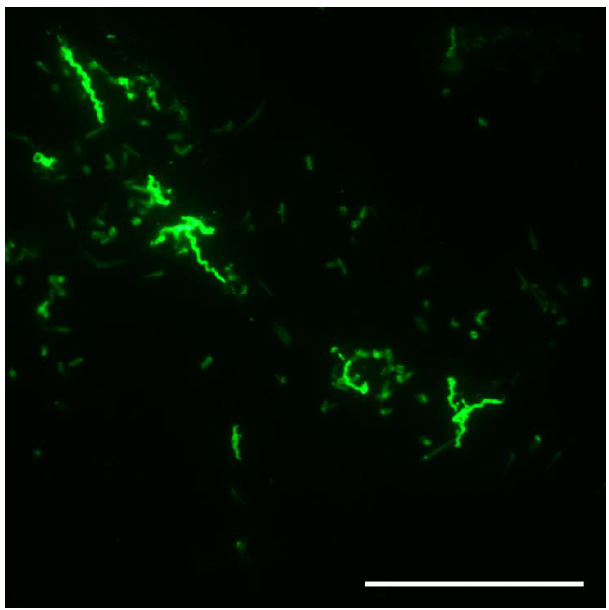
Figure 5. Borrelia hermsii in an unfed O. hermsi larva stained with anti-Vtp monoclonal antibody and goat anti-mouse FITC. Scale bar = 40 µm. goat anti-mouse FITC. Scale bar = 40 µ